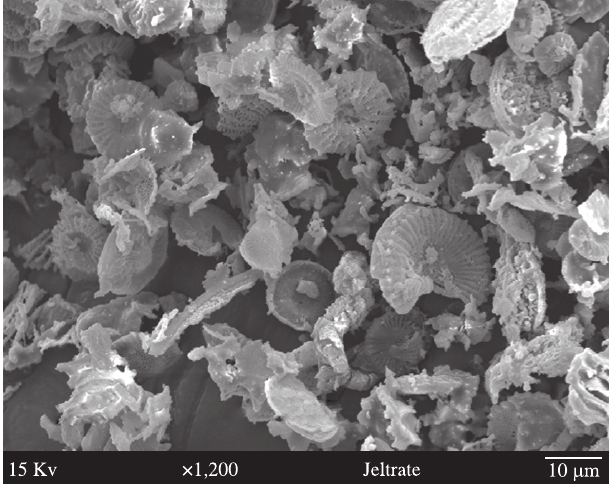
Figure 1. Typical scanning electron photomicrograph of Jeltrate inorganic fraction. Particles can be seen with several shapes and sizes, presenting a circular structure and a helical form with various perforations.